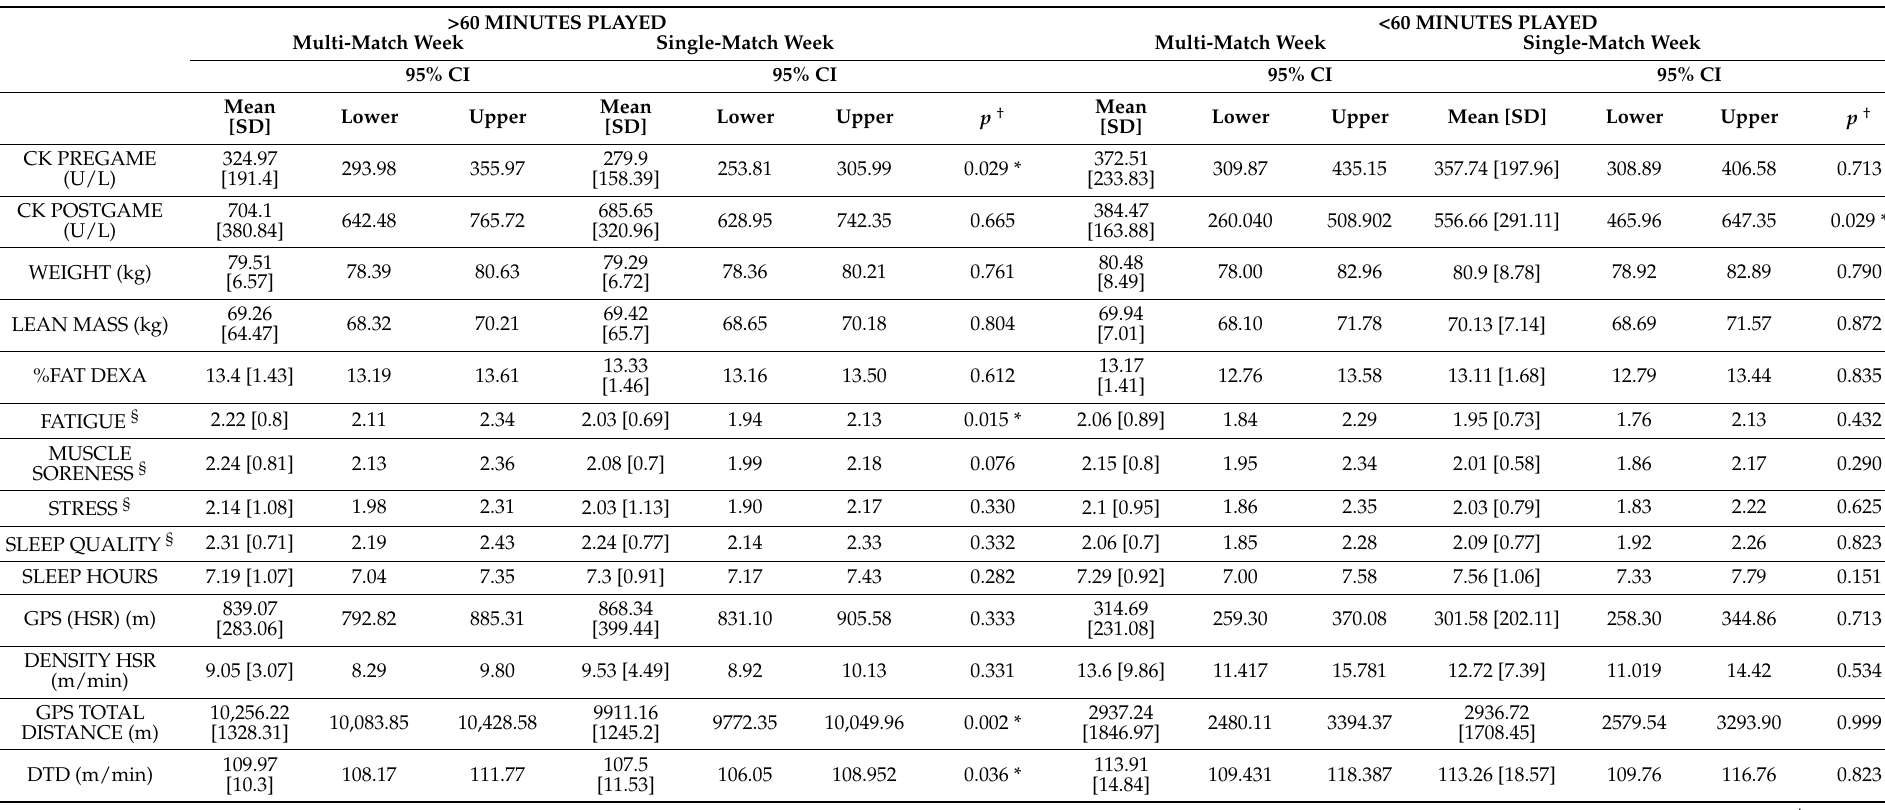
Table 2. Comparative assessment of muscle damage, wellbeing, body composition and match performance data in multi-match vs. single-match weeks in soccer players that completed more than 60 min in the game vs. those who played